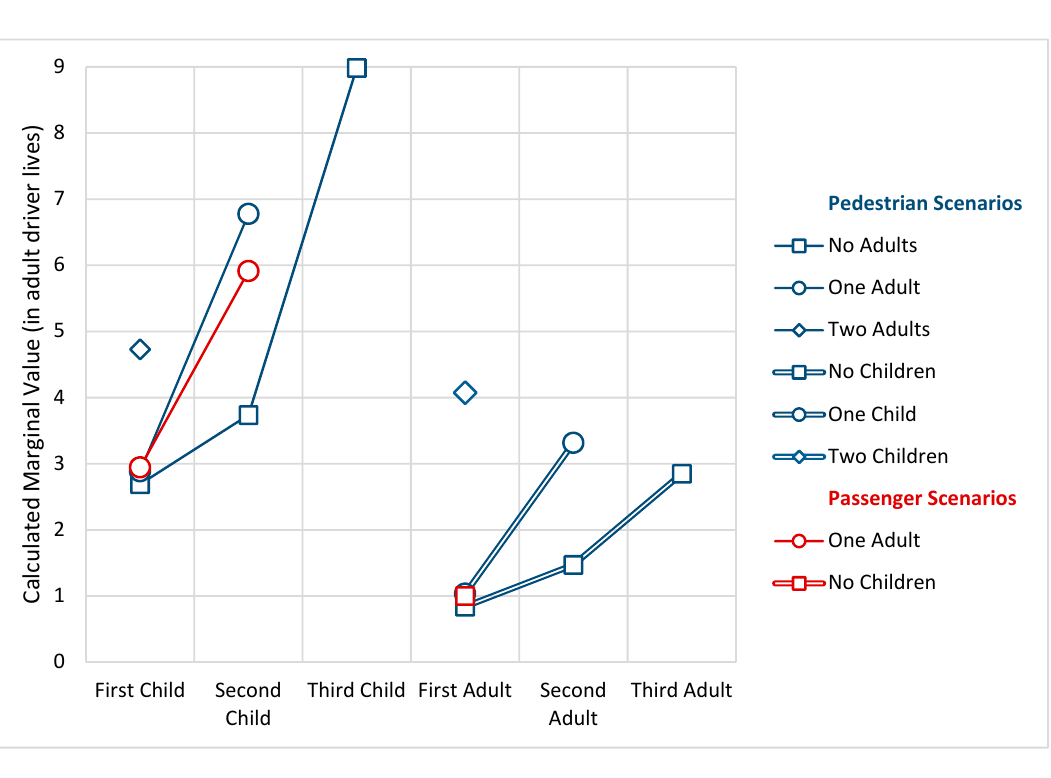
Figure 3. Calculated marginal value of life (expressed as adult driver lives) by number and age of other people involved in the accident.